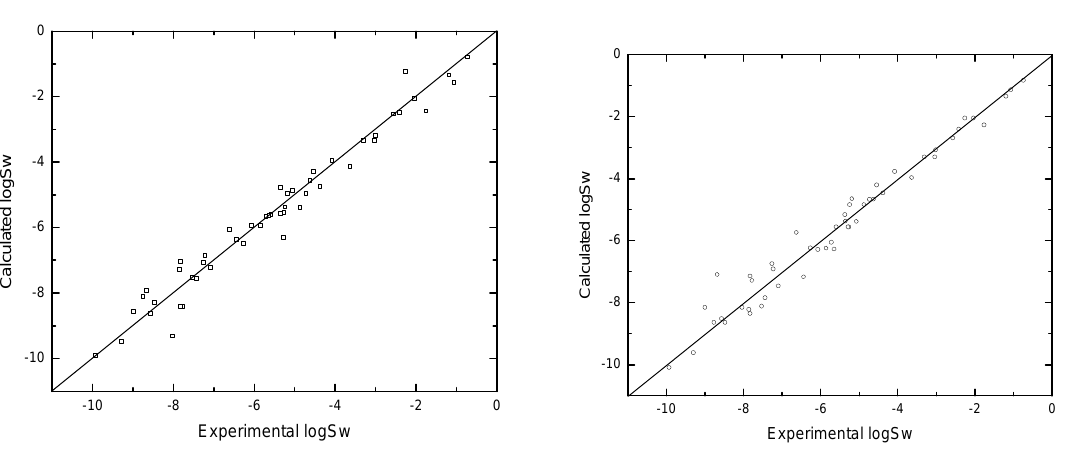
Figure 1 . Calculated values versus experimental values of logSw for the two models ( □ : Delgado, ○ : This